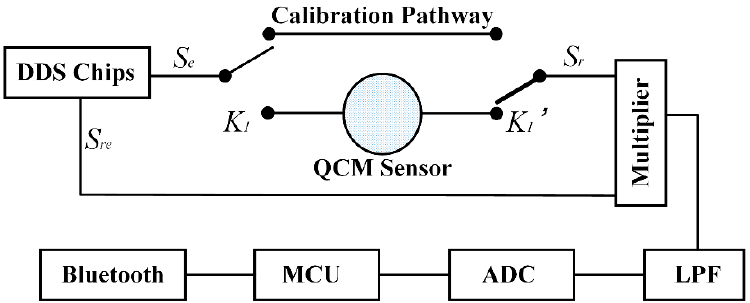
Figure 3. The principles of the test device design.